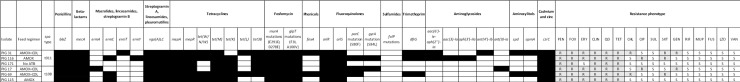
Resistance phenotype versus genotype obtained by whole genome sequencing for six ST398-MRSA representative isolates from pigs receiving different antibiotic feed regimens (amoxicillin + colistin, amoxicillin only, and no antibiotics).Black squares indicate presence of gene.